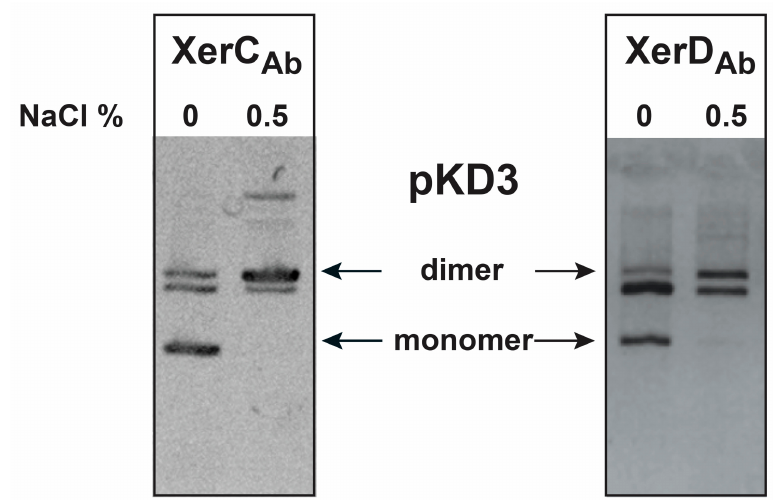
Figure 2. Resolution of plasmid dimers. Dimers of the plasmid pKD3 were introduced by transformation into E. coli DS981XerC Ab or E. coli DS99028XerD Ab . The cells were cultured